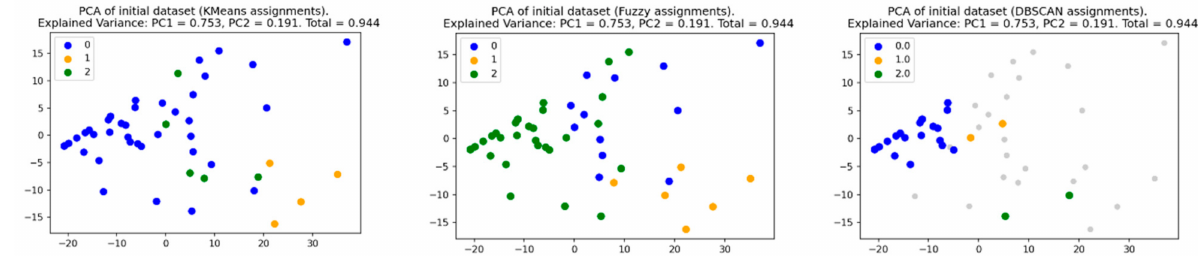
Figure 5. Cluster analysis in the initial measurement (two weeks after the beginning of the semester) with the k -means ++, fuzzy k -means, density-based spatial clustering of applications with noise (DBSCAN) algorithms.